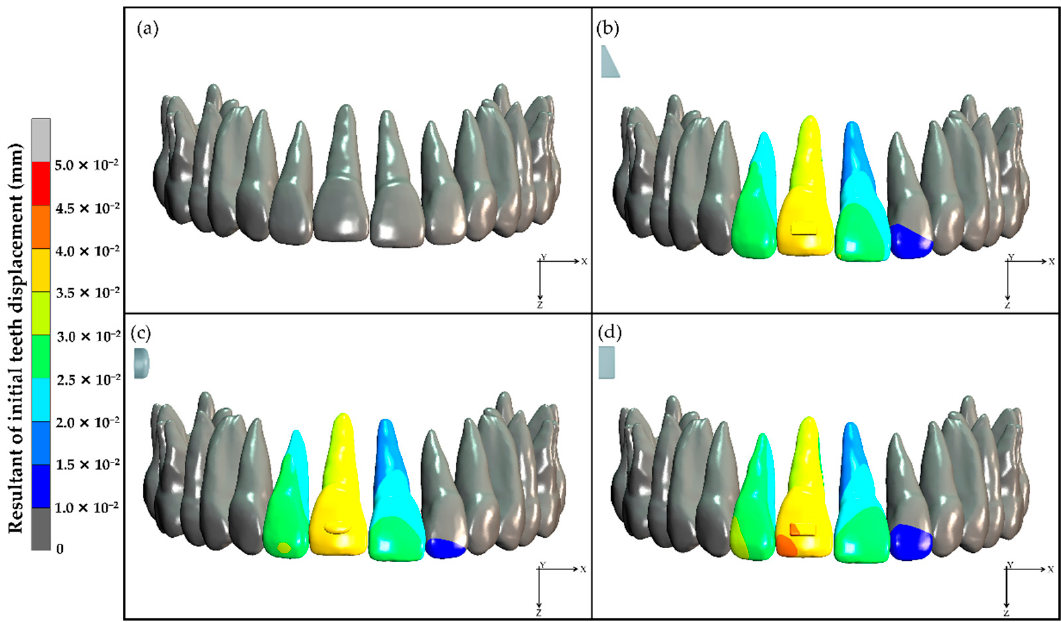
Figure 3. Resultant values of initial teeth displacement: ( a ) no composite attachment, ( b ) rectangular beveled attachment, ( c ) ellipsoid attachment, and ( d ) horizontal rectangular